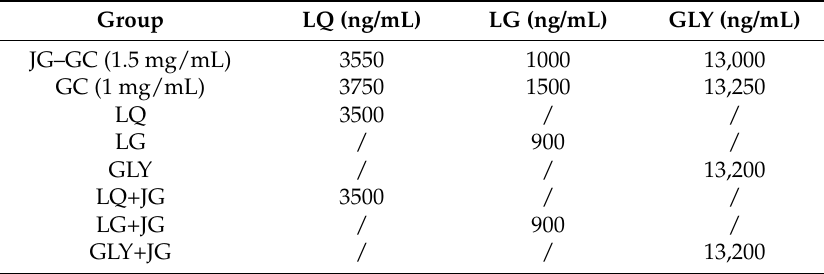
Table 4. Concentration of the analytes in each group.